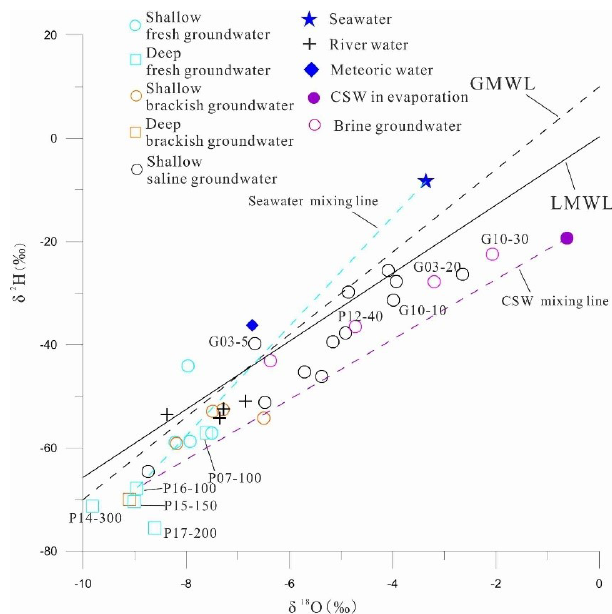
Figure 4. Stable isotope compositions of different water samples. Seawater mixing line: mixing between deep fresh groundwater and seawater; CSW mixing line: mixing between deep fresh groundwa- ter and CSW.